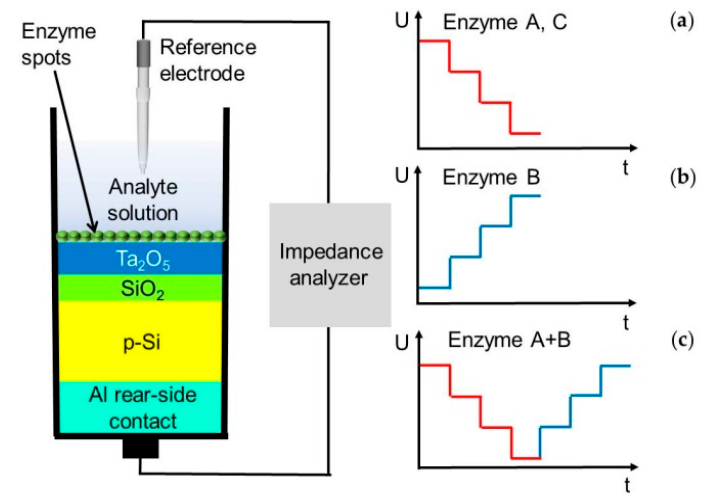
Figure 1. Schematic measurement set-up of modified capacitive electrolyte-insulator-semiconductor (EIS) sensor by a fully spotted enzyme layer on top (left); expected constant capacitance (ConCap) curve depending on the applied enzyme A (penicillinase) ( a ), B (urease) ( b ), C (glucose oxidase) ( a ), or A and B together ( c ) on the same chip (right).